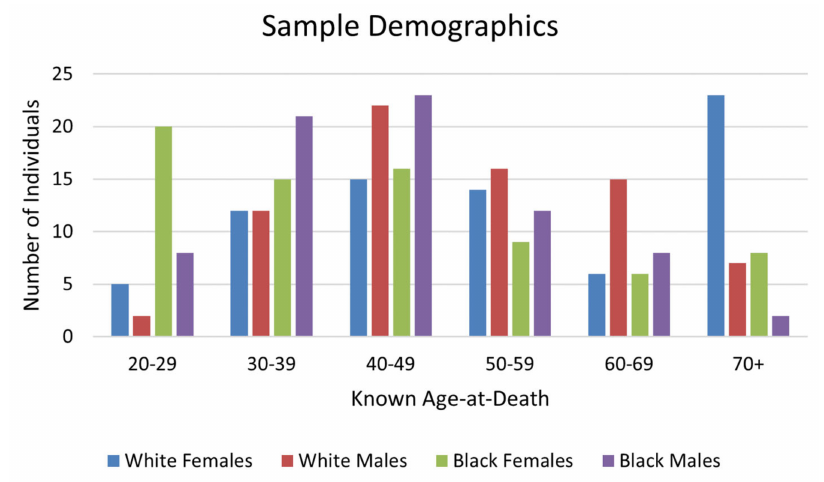
Figure 1. Sample